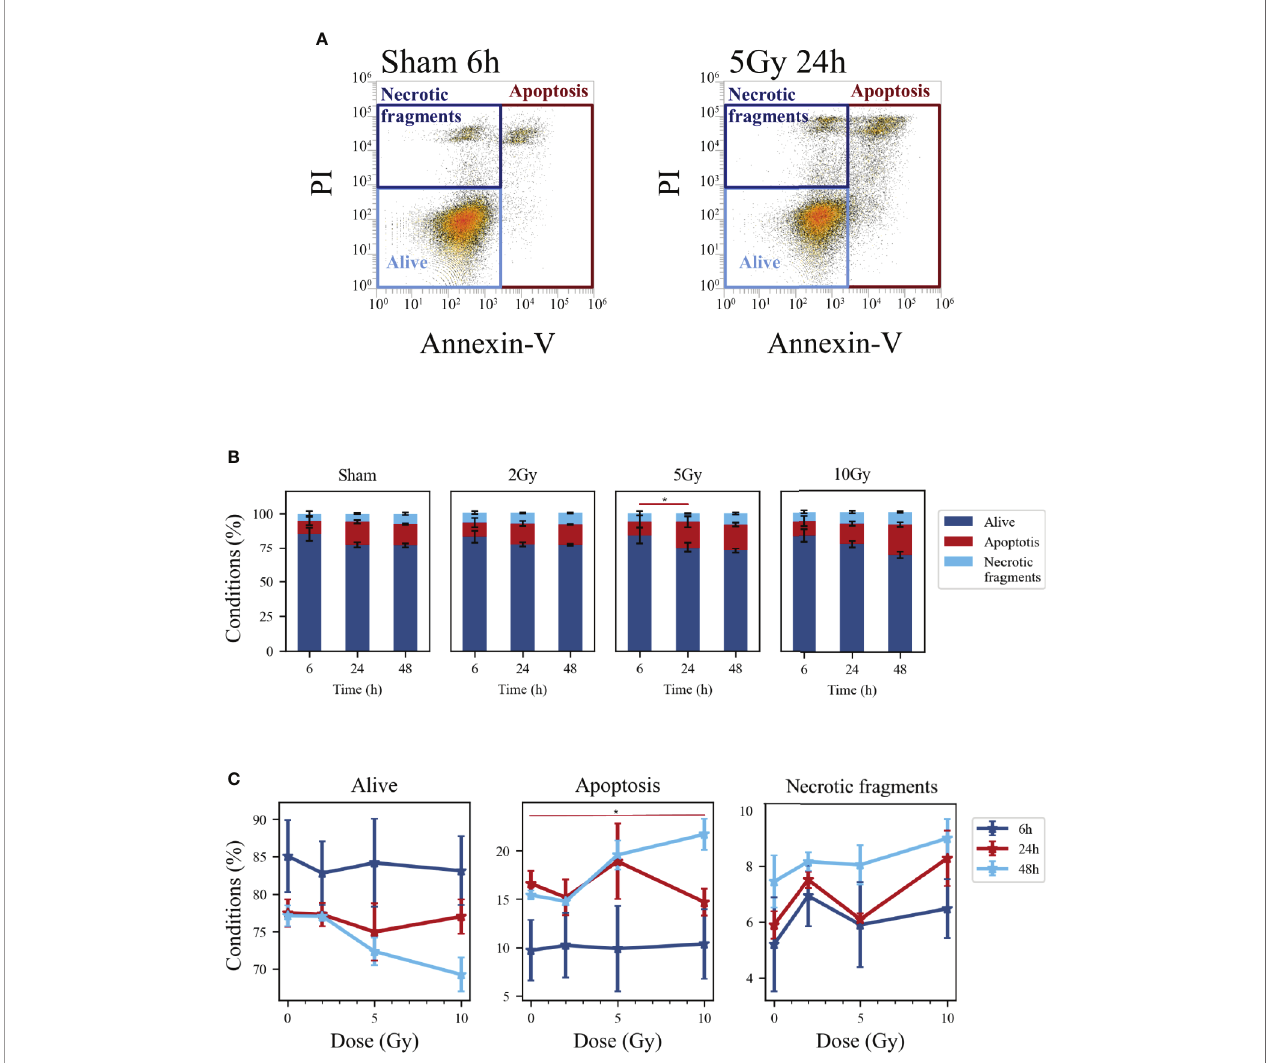
FIGURE 5 | Cell death analysis with fl ow cytometry following the “ Treat + Seed ” protocol. (A) Gating strategy to identify in the Caco-2 population living cells (Alive), apoptotic cells (Apoptosis) and any intermediate cell death form (Necrotic fragments) in the biparametric plot of Annexin V vs. PI signals, demonstrated with illustrative data for: sham condition at 6 h (left); 5-Gy-irradiated cells at 24 h (right). (B) Percentages of living, apoptotic cells and necrotic fragments for the different irradiation conditions as a function of time. (C) Percentages of living, apoptotic cells and necrotic fragments for the different time points as a function of X-ray dose (same data as in panel B, lines are a guide to the eye). Data reported are mean ± SEM, obtained from ≥ 3 independent experiments. Statistical signi fi cance (post-hoc pairwise comparisons with Bonferroni correction) is as follows: *p <